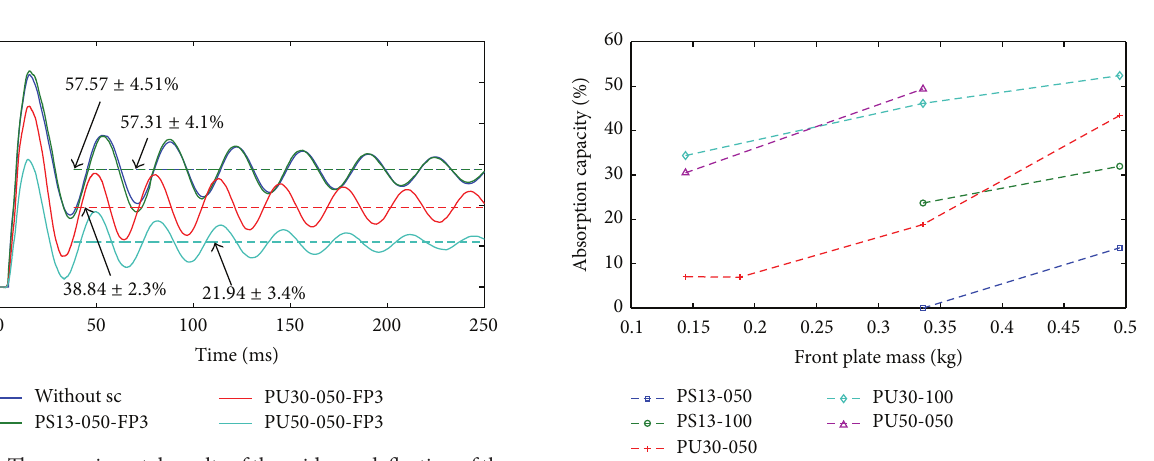
Figure 14: The experimental results of the midspan deflection of the steel beam with PS13-050-FP3, PU30-050-FP3, and PU50-050-FP3.